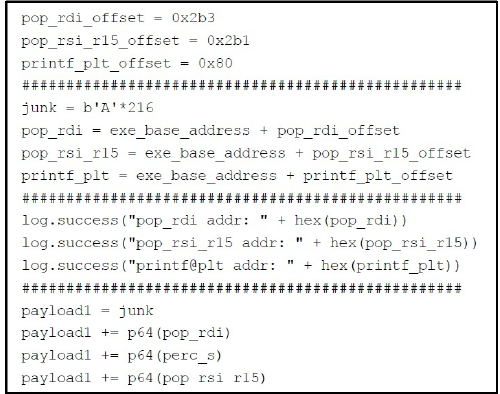
Figure 26. Python Script Part 2.